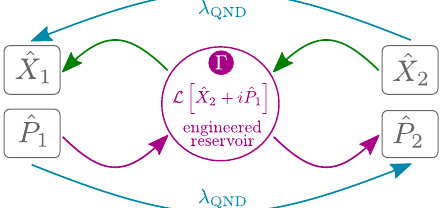
FIG. 4. Schematic illustrating the directional phase-sensitive amplifier. The coherent QND Hamiltonian of Eq. (25) causes the cavity-1 P quadrature to drive the cavity-2 P quadrature, and the cavity-2 X quadrature to drive the cavity-1 X quadrature (blue arrows); there is gain associated with each of these drivings, cf. Eq. (27). The engineered reservoir [jump operator described by Eq. (26)] also mediates the same drivings (green and magenta arrows), again with gain. By balancing these interactions, one can cancel the X 2 → X 1 driving, resulting in directional